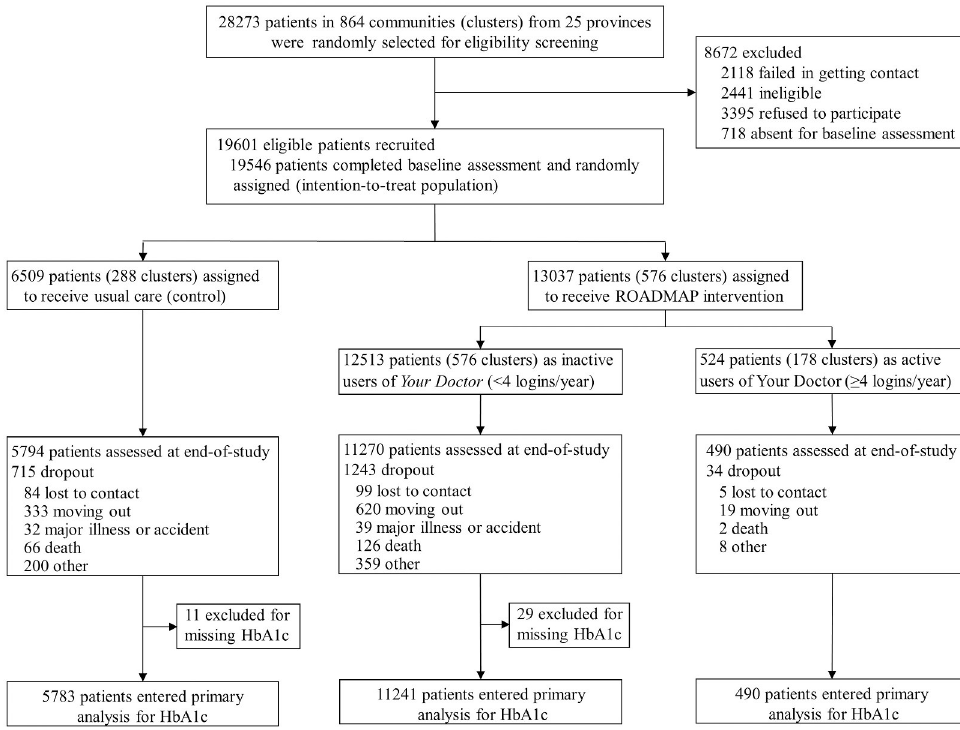
Fig 1. Participant flowchart. H AU : AnabbreviationlisthasbeencompiledforthoseusedthroughoutFig 1 : Pleaseverifythatallentriesarecorrect : bA1c, glycated hemoglobin; ROADMAP, Road to Hierarchical Diabetes Management at Primary Care Settings in China.